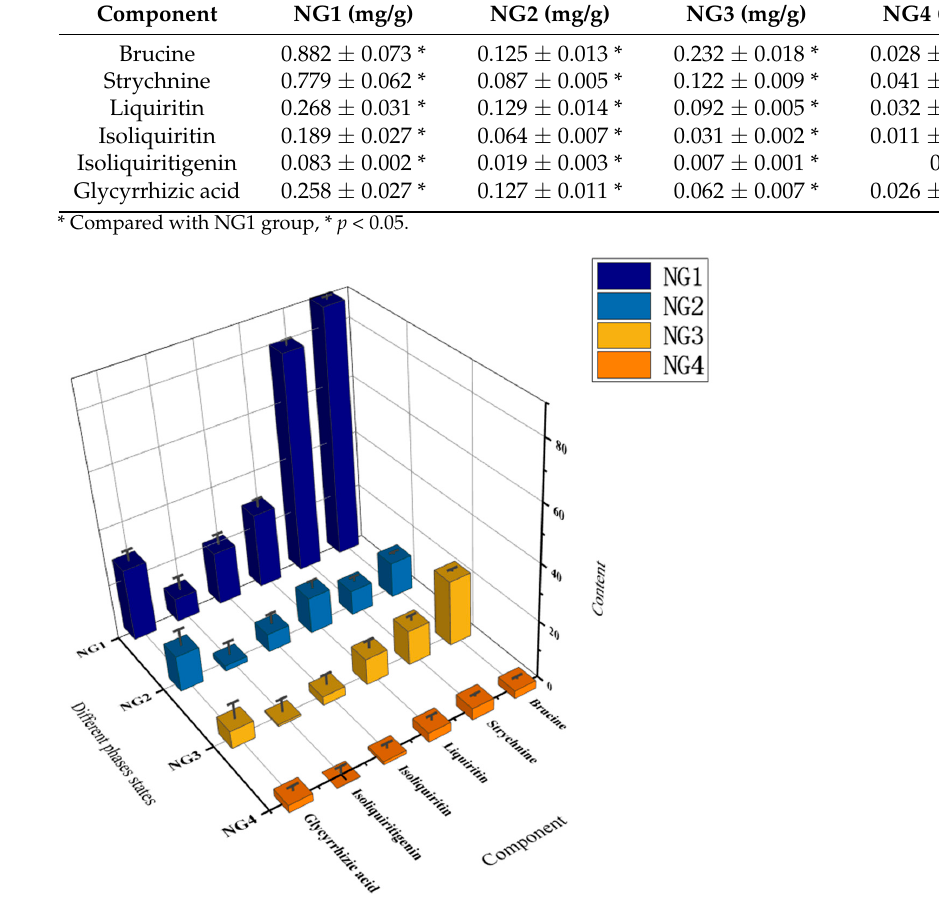
Figure 3. A comparison of the concentration of the six components in different phase